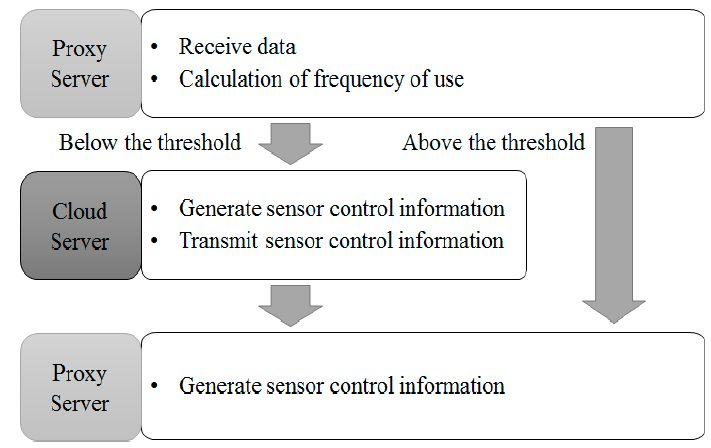
Figure 11. Structure of Usage-Based Communication Control.